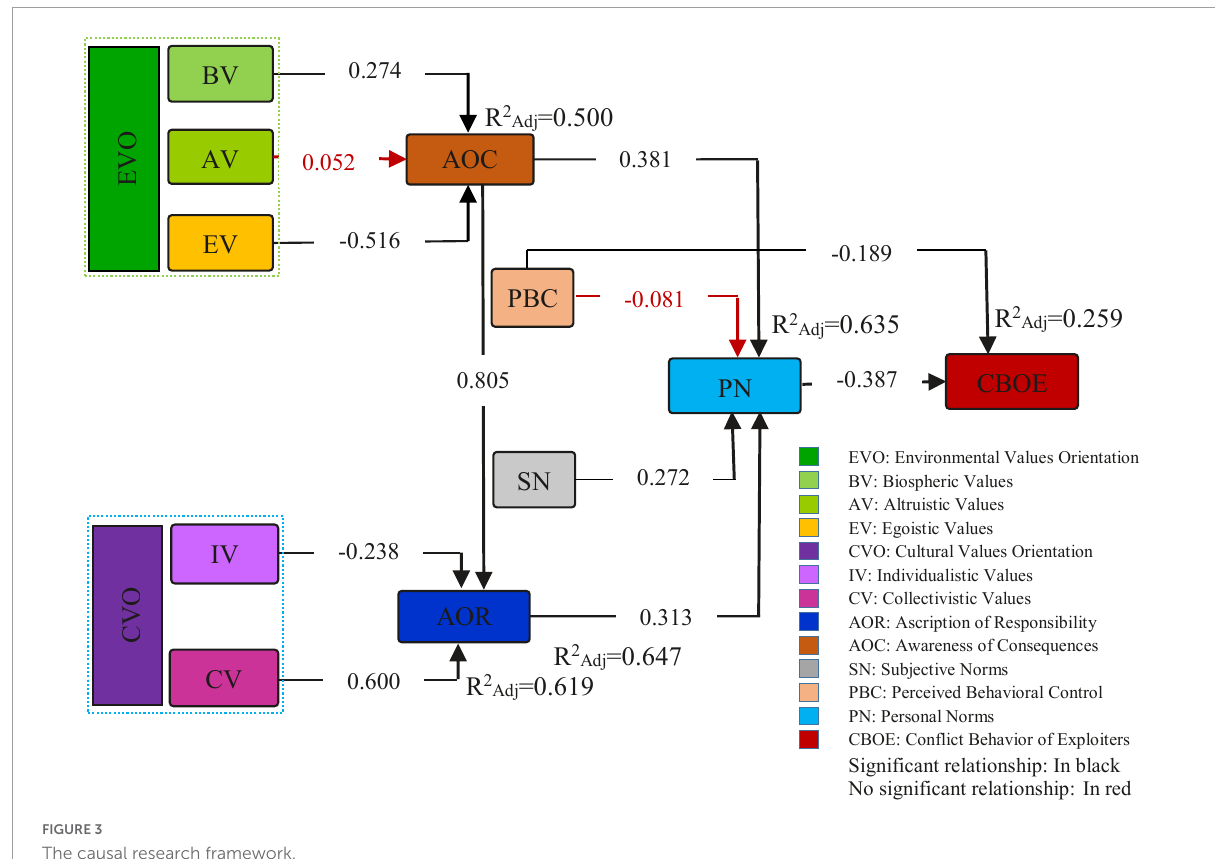
FIGURE3 The causal research